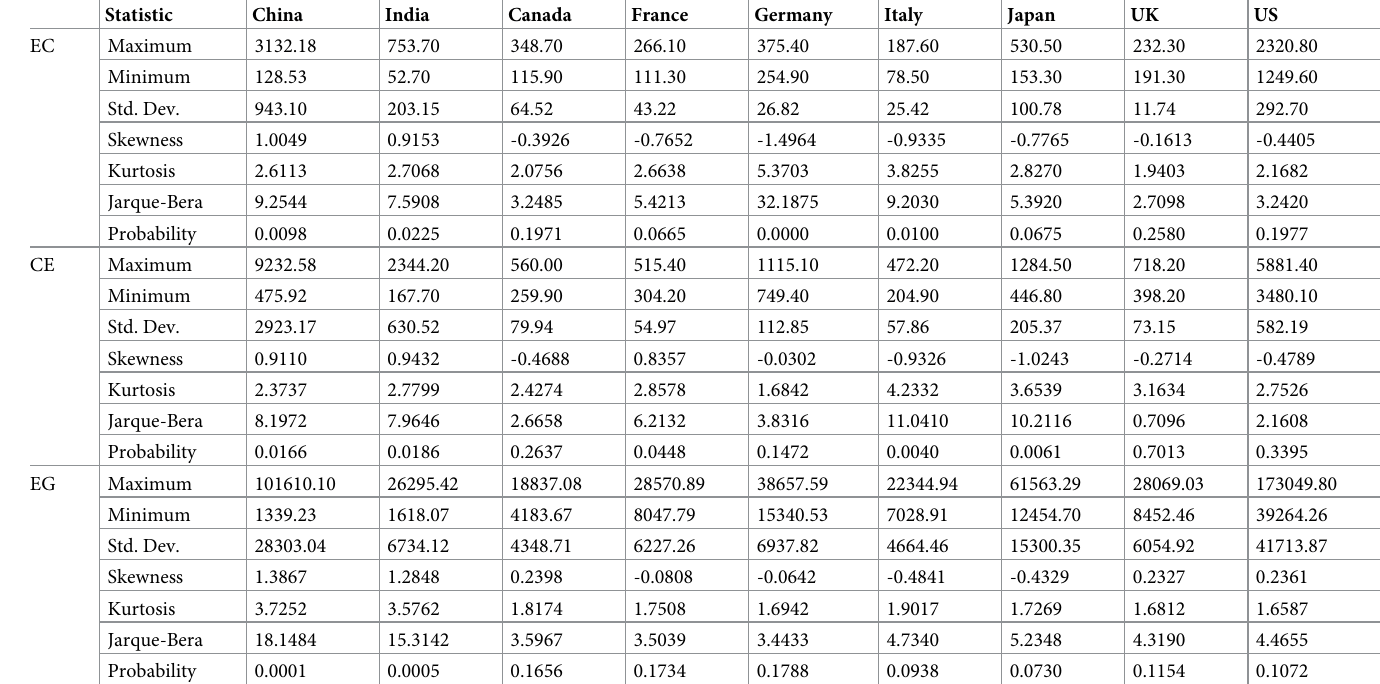
Table 1. Descriptive statistics for the aggregate